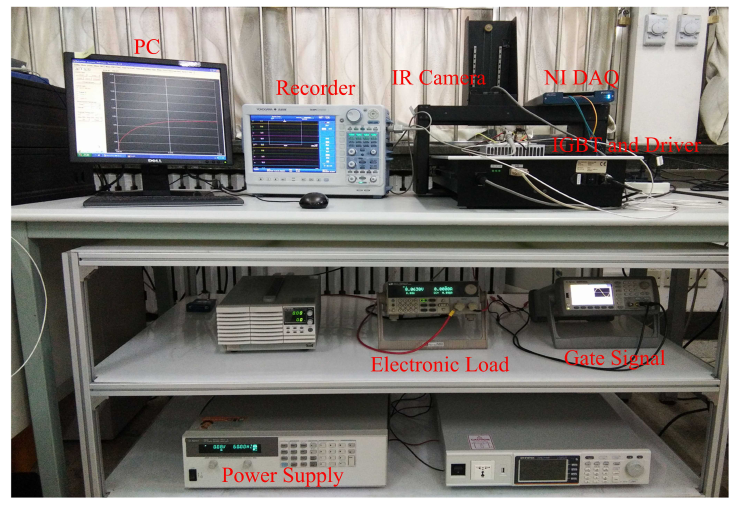
Figure 7. The actual experimental